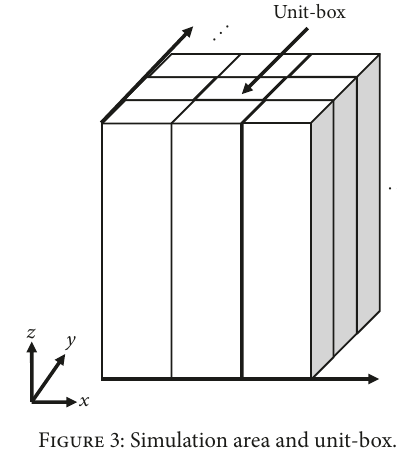
Figure 3: Simulation area and unit-box.